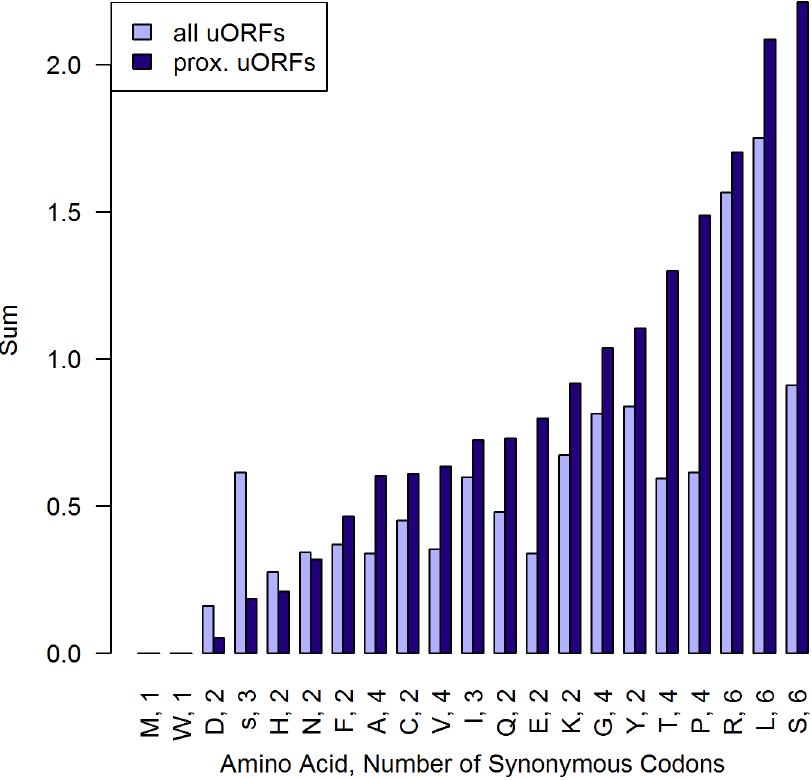
Fig 2. Sum of absolute log2(codon frequency CDS/uORF). For each subgroup of synonymous codons, the sum of the absolute value log2 of codon usage ratio CDS/uORF was calculated, taking BSF stage as an example (for all stages see S10 Fig). Greater values represent subgroups of synonymous codons that are relatively more biased in their usage between uORFs and CDSs. Particularly proximal uORFs show distinct variation from the CDSs codon usage. (n alluORFsBSF = 15,348 n prox.uORFsBSF =